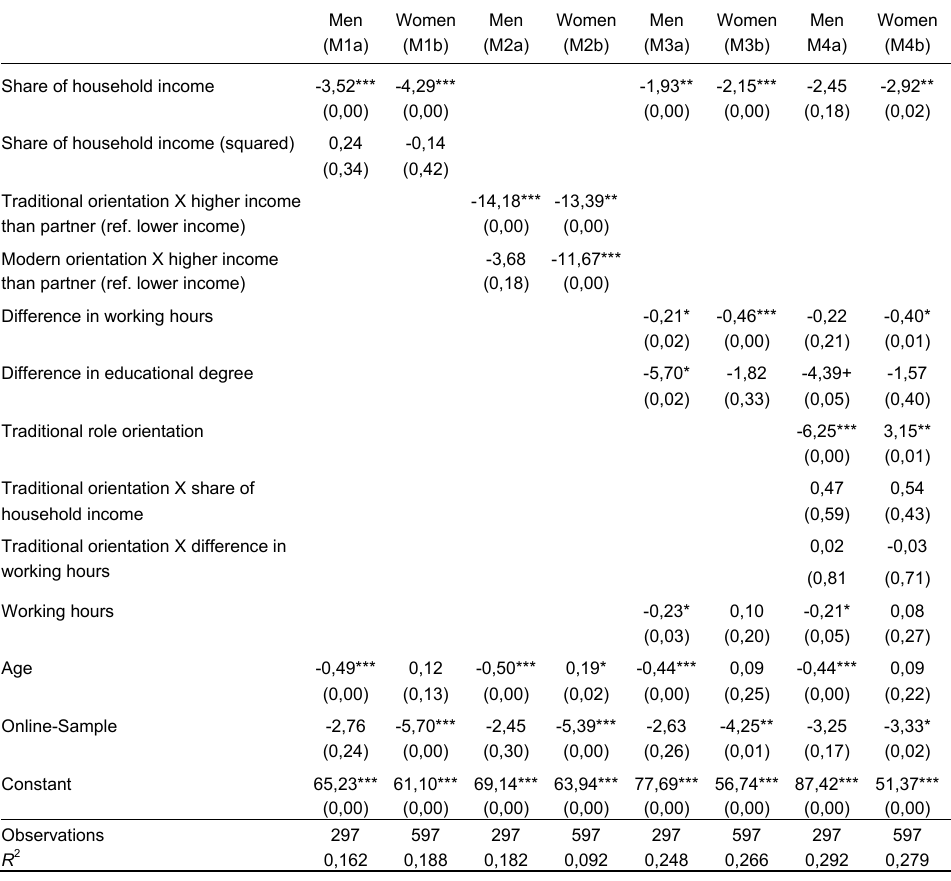
Table 2 : Linear regression on housework (Focus: Relative